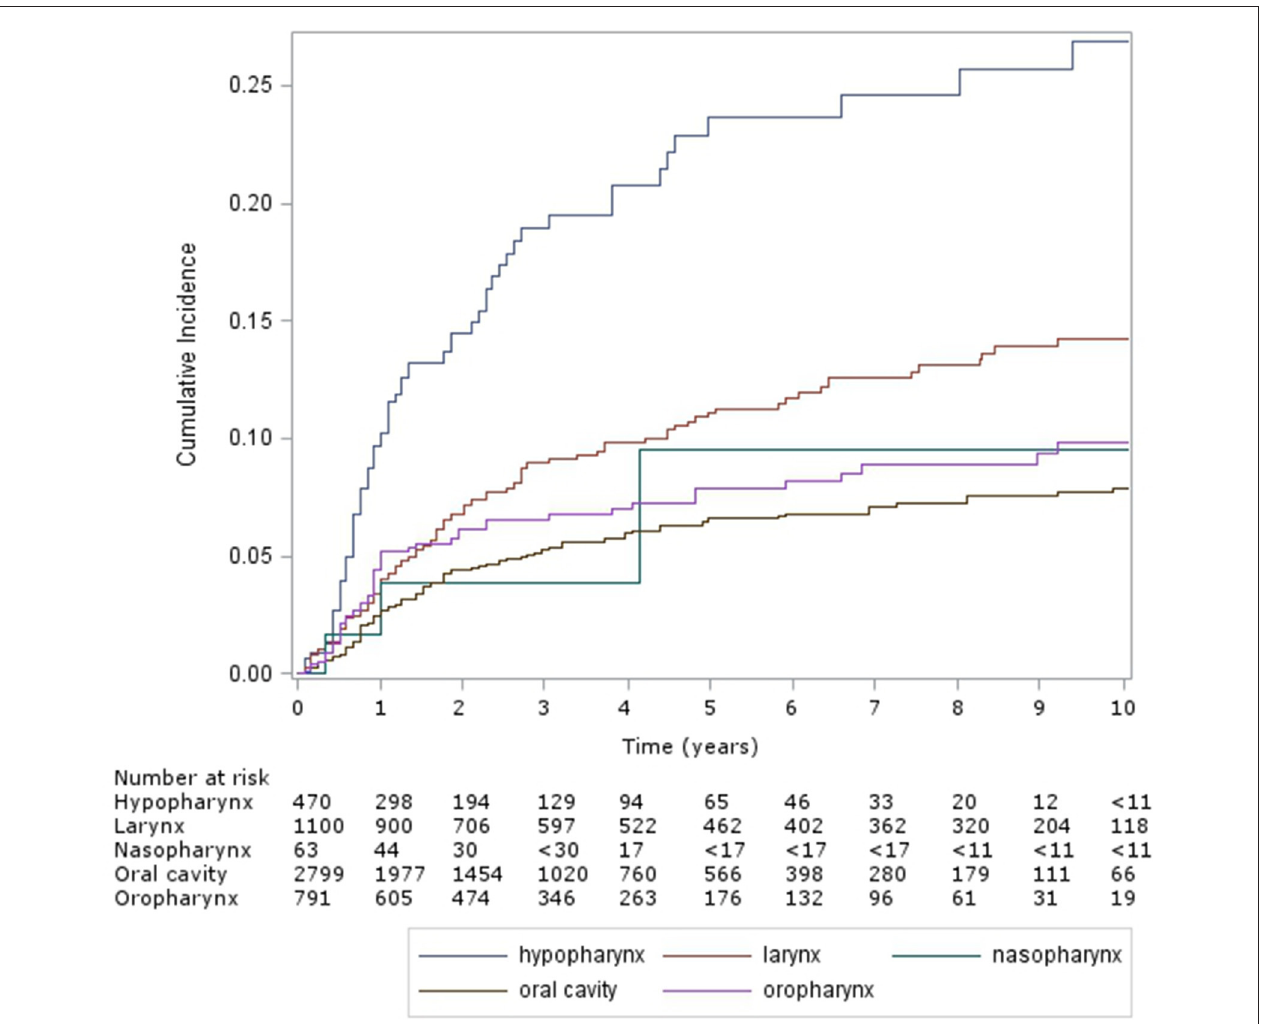
FIGURE 2 | Cumulative incidence of esophageal dilation by site (Hypopharynx, Oral Cavity, Larynx, Nasopharynx,